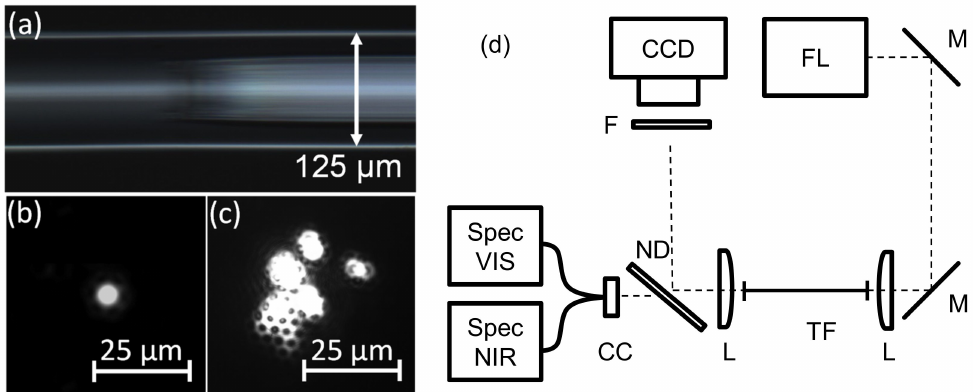
Figure 2. ( a ) Taper used to e ffi ciently couple pump light into the microstructure, ( b) core-coupled light spatial intensity pattern at 1060 nm and ( c ) cladding-coupled light intensity pattern at 1060 nm. Both images were captured on a logarithmic camera. ( d ) Shows the schematic of the optical setup with FL, fiber laser; M, mirror; L, lens; TF, test fiber; ND, reflective neutral density filter; CC, cosine corrector; F, bandpass filter; CCD, camera; and Spec,